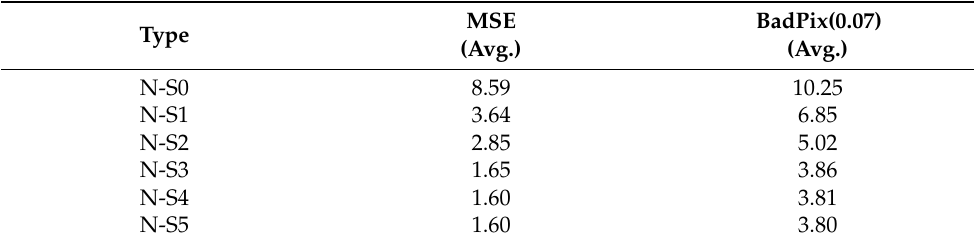
Table 4. Performance comparison of networks with the different number of